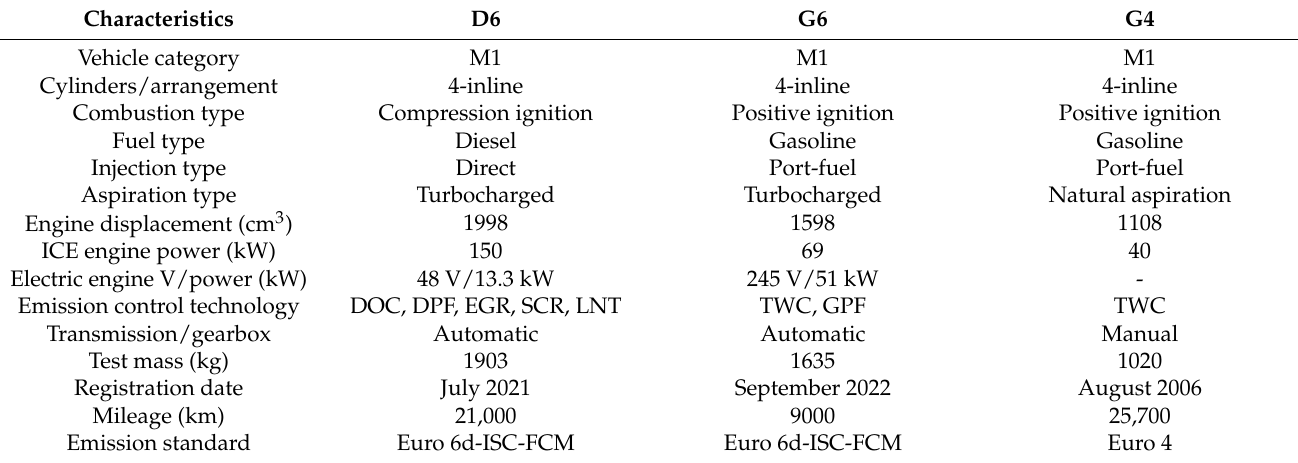
Table 2. Characteristics of